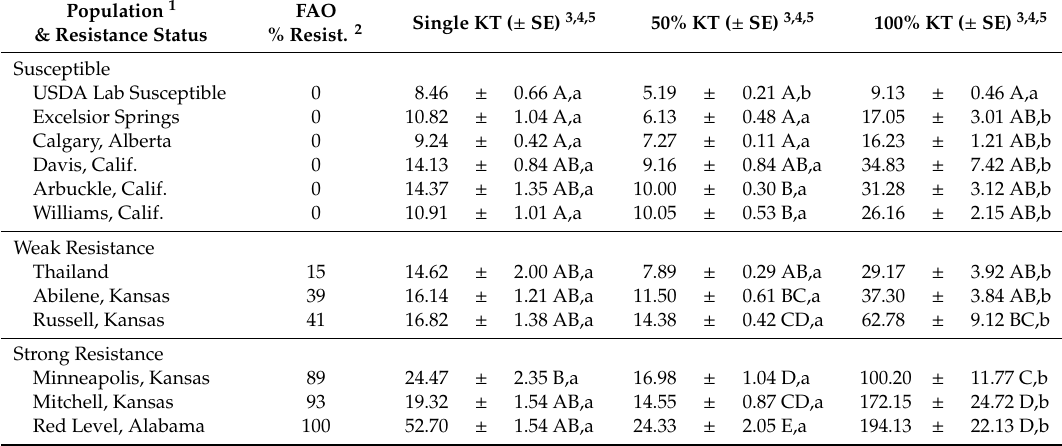
Table 1. Mean knockdown time (KT) in minutes for populations of adult Tribolium castaneum assayed as single beetles or as groups of 10 for knockdown of 50% or 100% of the